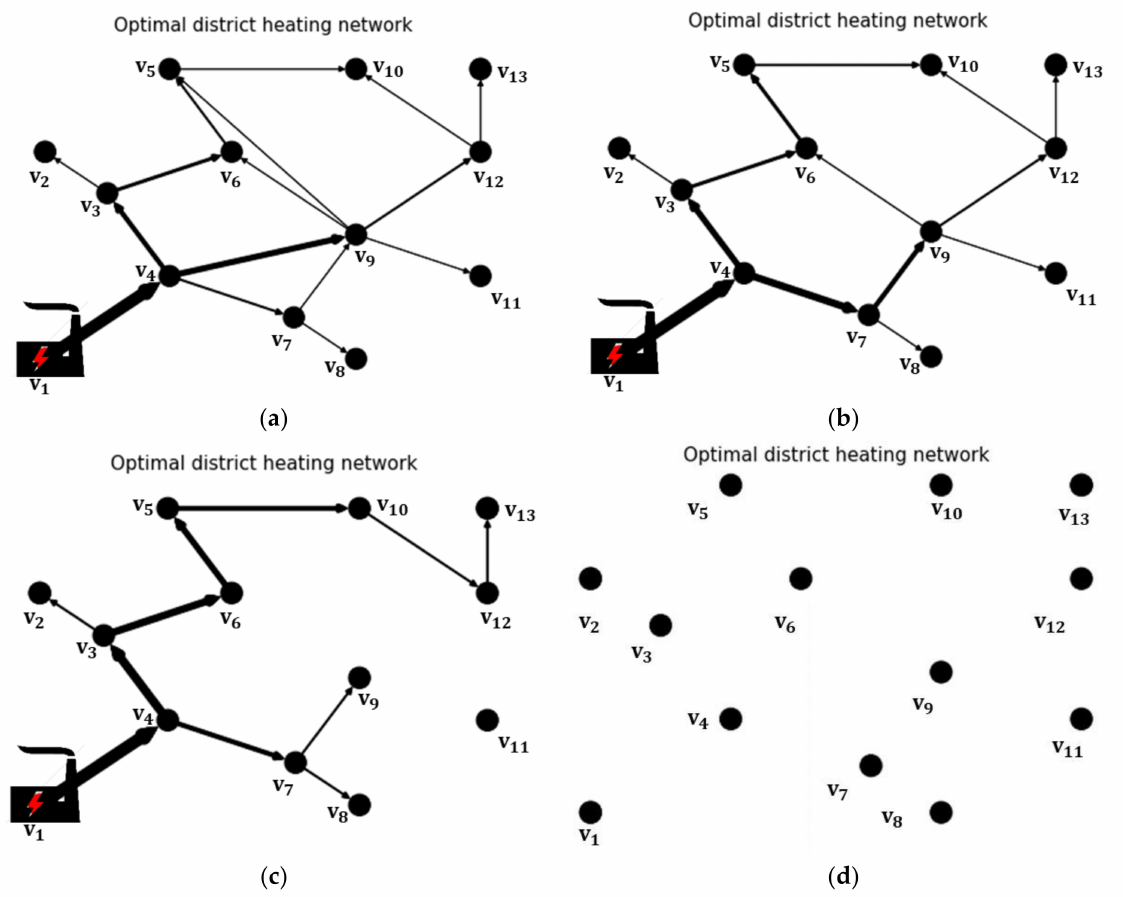
Figure 9. ( a ) r heat = 0.07 € /kWh; ( b ) r heat = 0.06 € /kWh; ( c ) r heat = 0.05 € /kWh; ( d ) r heat = 0.04 €